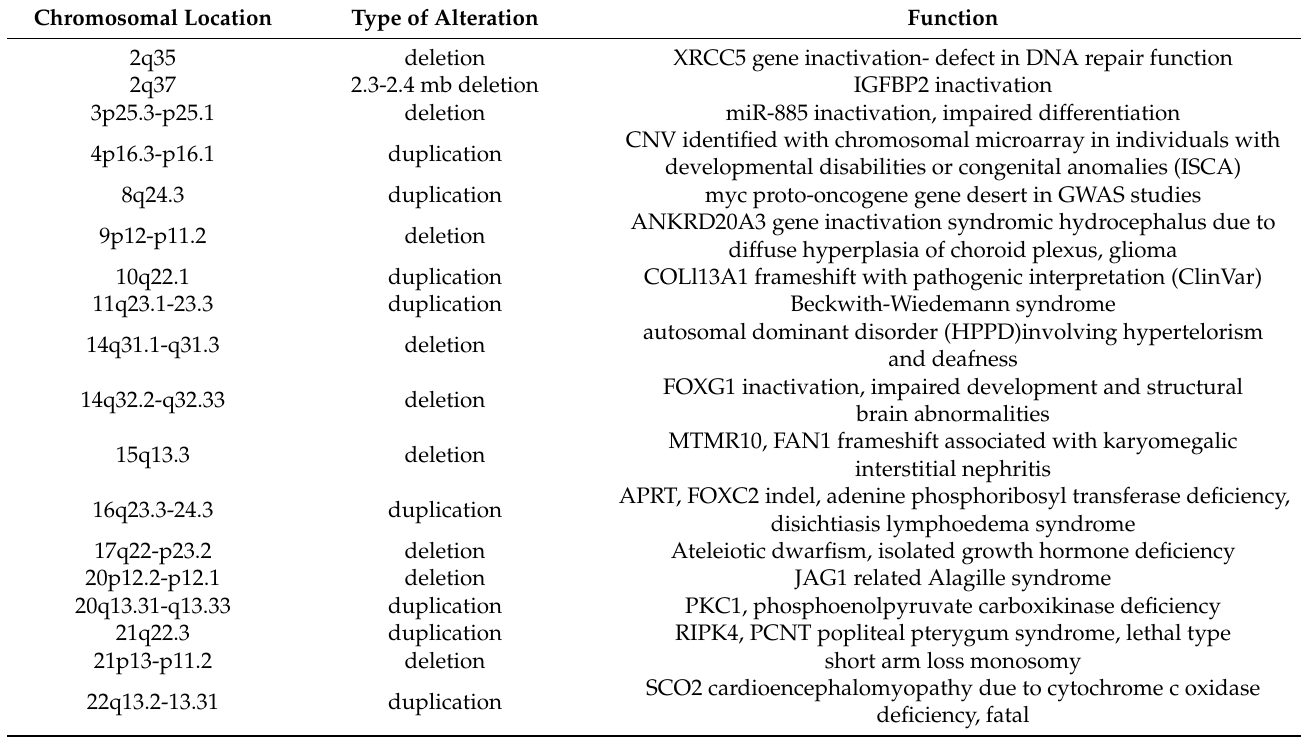
Table 2. Chromosomal alterations found in missed aborted embryos and listed in human genetic databases (UNIQUE, Genetic Alliance and